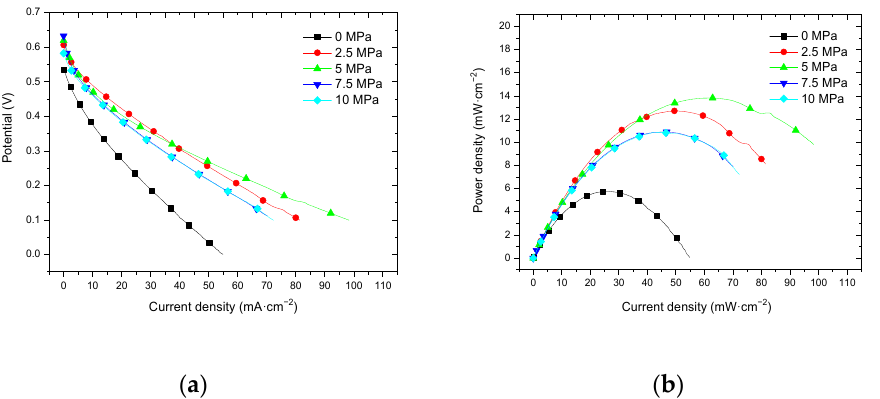
Figure 12. The effect of hot-pressing pressure on the performance of titanium mesh-based MEA at 60 ◦ C with an oxygen environment. ( a ) Curve between current density and voltage; ( b ) curve between current density and power